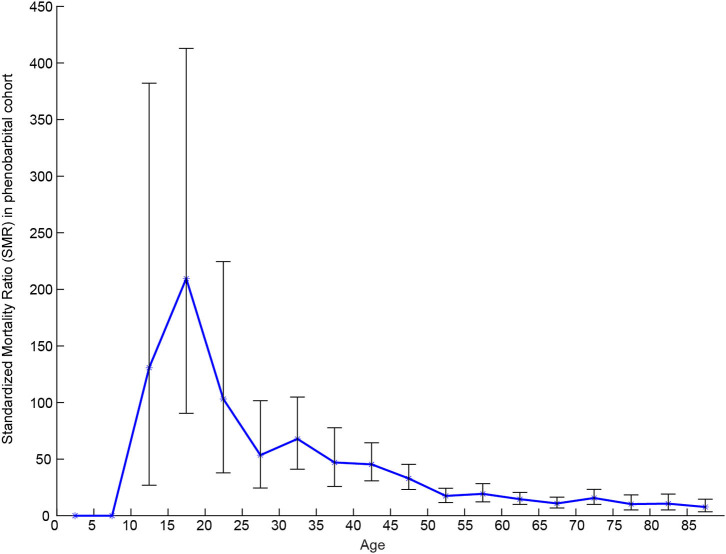
SMR of the PB group.